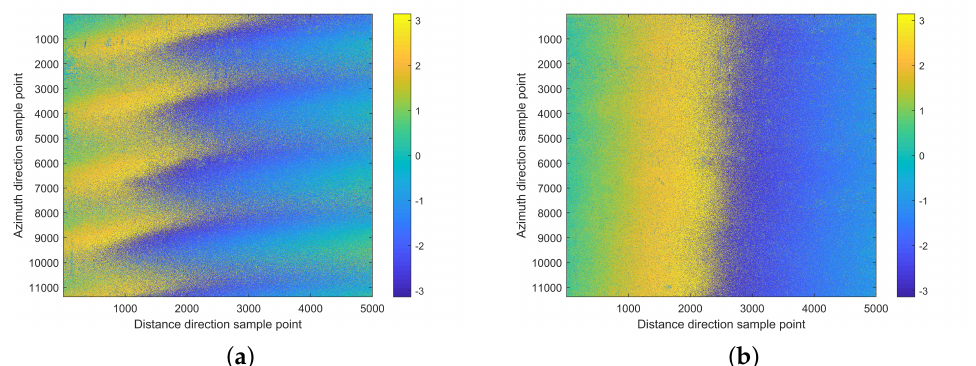
Figure 19. The comparison of interference fringe results. ( a ) The main POS imaging; ( b ) The left POS